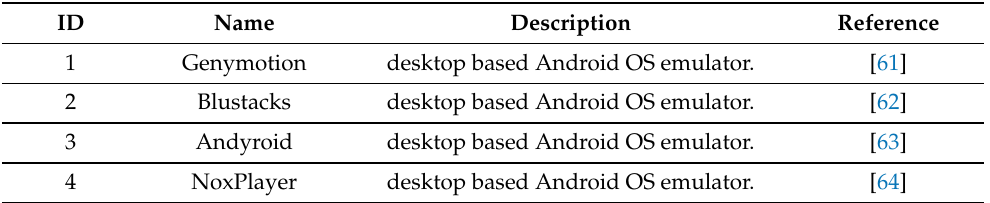
Table 13. Tools used for mobile applications and services emulation.